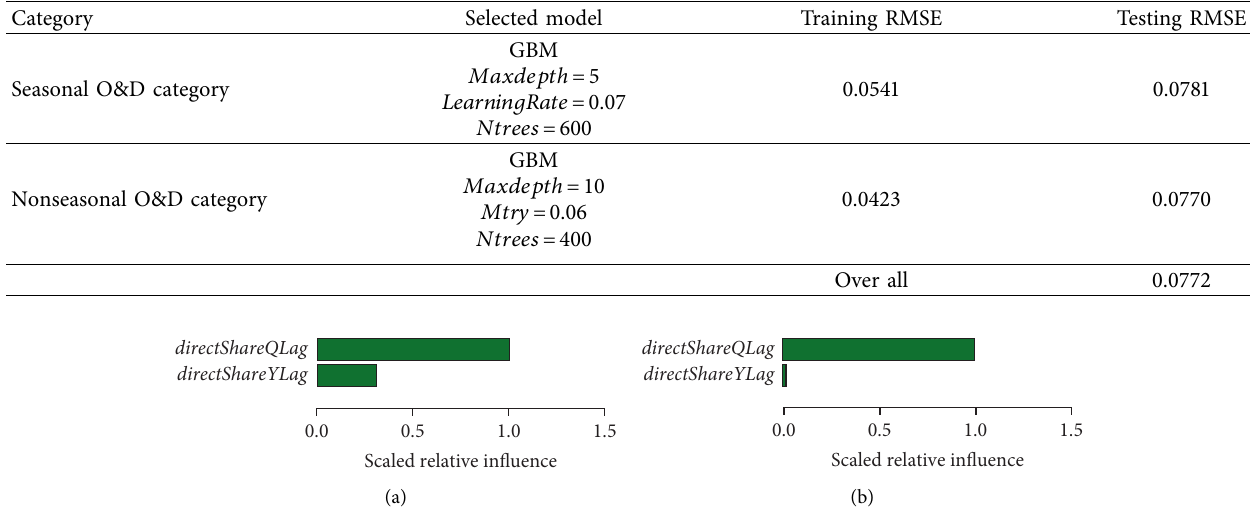
Figure 7: Category-based learning process. Table 5: Category-based model performance.